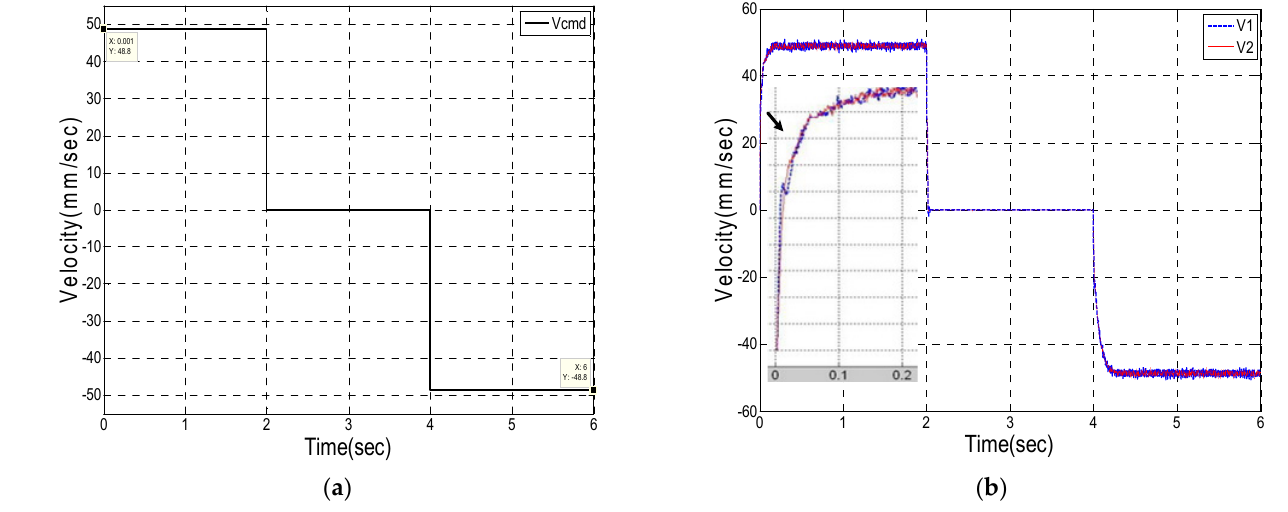
Figure 4. ( a ) Velocity command; ( b ) velocity response. Table 1. Identified parameters of gantry stage.